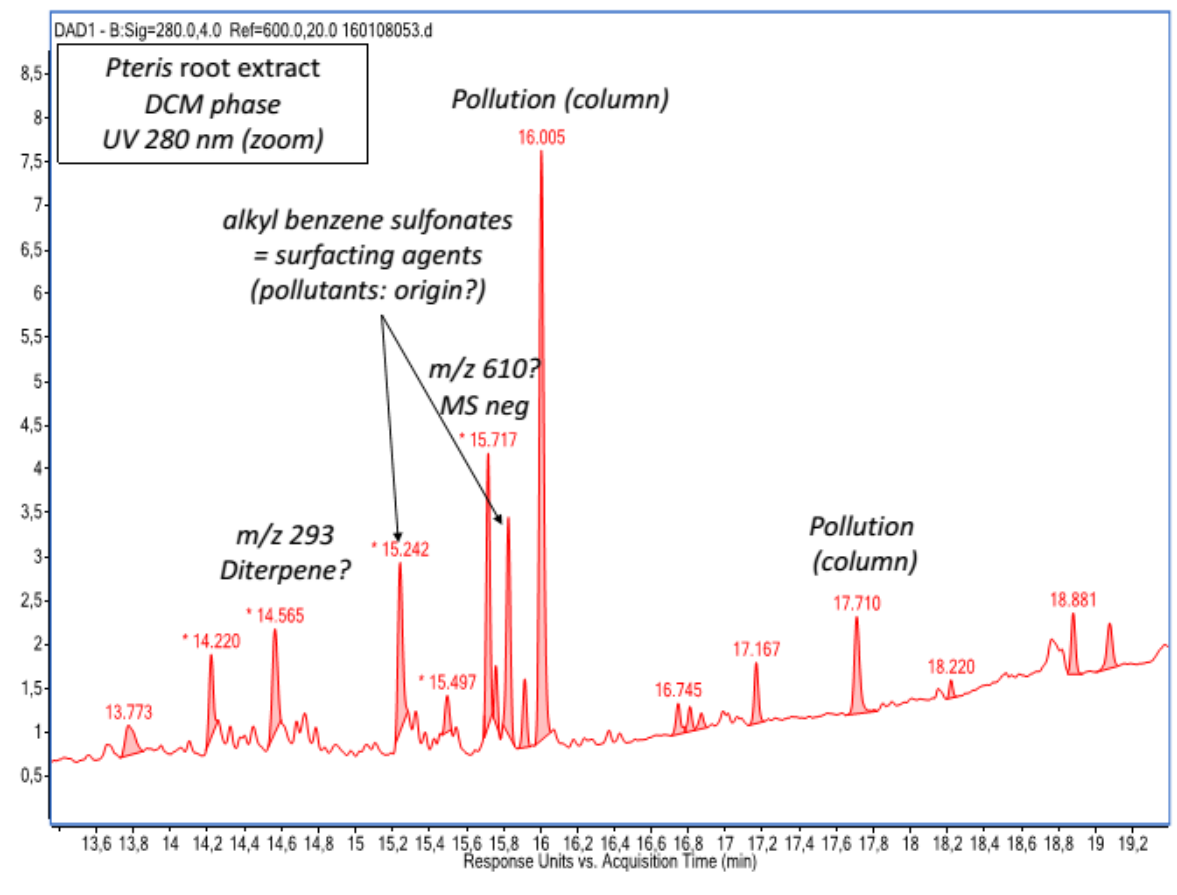
Figure A4. Chemical composition of P. vittata L. roots DCM fraction from the tape-strips analysis.